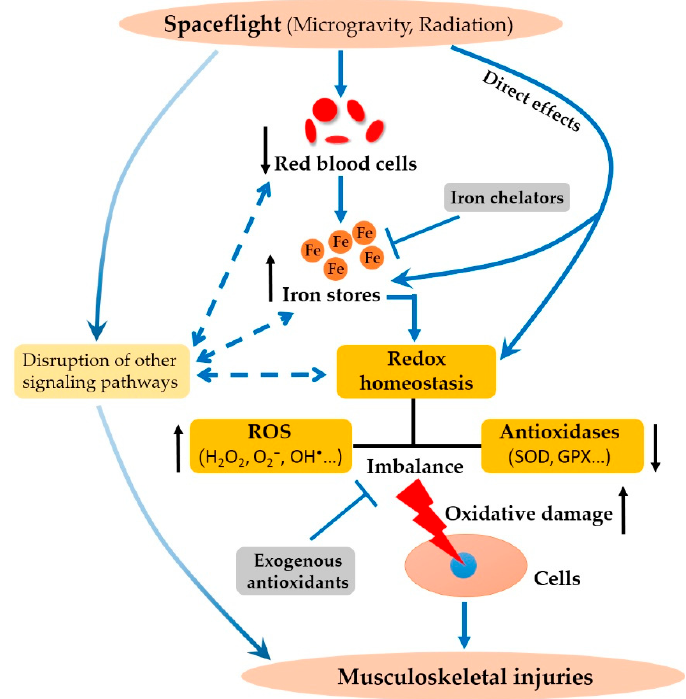
Figure 1. Hypothetical model on how spaceflight leads to injuries in the musculoskeletal system. Exposure of tissues to the spaceflight environment, such as microgravity and radiation, leads to a decreased mass of red blood cells. This induces elevated iron stores, due to iron release from destroyed erythrocytes. Excess iron leads to an imbalance in redox homeostasis, owing to increased levels of reactive oxygen species (ROS) and reduced levels of antioxidases. The spaceflight environment may also have direct effects on iron metabolism and redox homeostasis. The imbalance of redox status leads to the oxidative damage of cells, which in turn result in injuries in the musculoskeletal system. Other signaling processes are disrupted by the spaceflight environment, and may also cause these defects. Some exogenous iron chelators and antioxidants may block the increases in iron and the imbalance in redox status, thereby preventing oxidative damage.